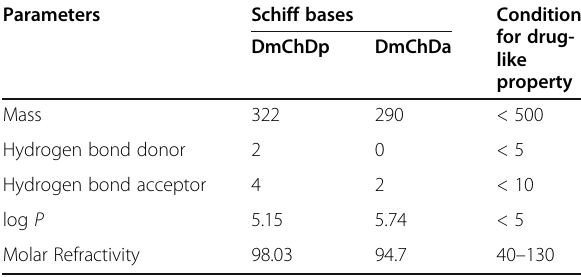
Table 2 Lipinski rule of